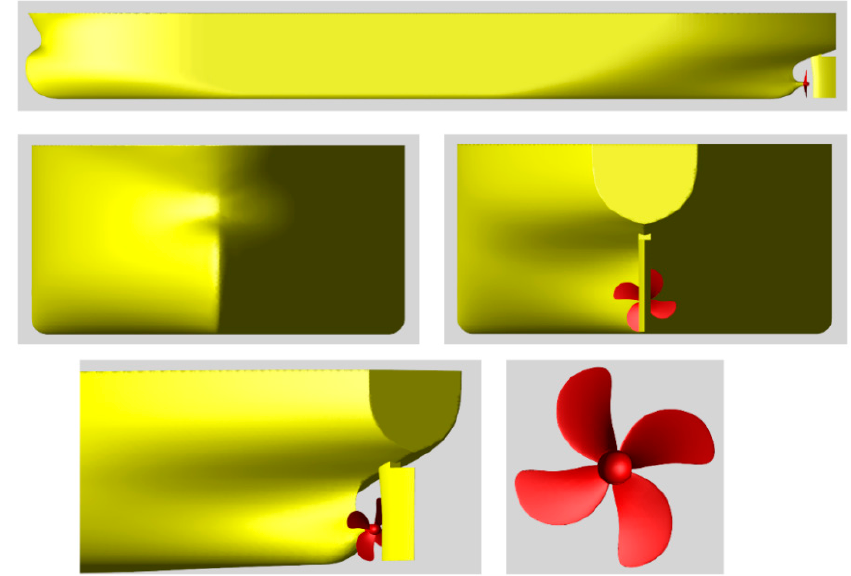
Figure 6. Configuration of target hull and propeller. Table 3. Comparison of resistance of model-scale ship between EFD and CFD.